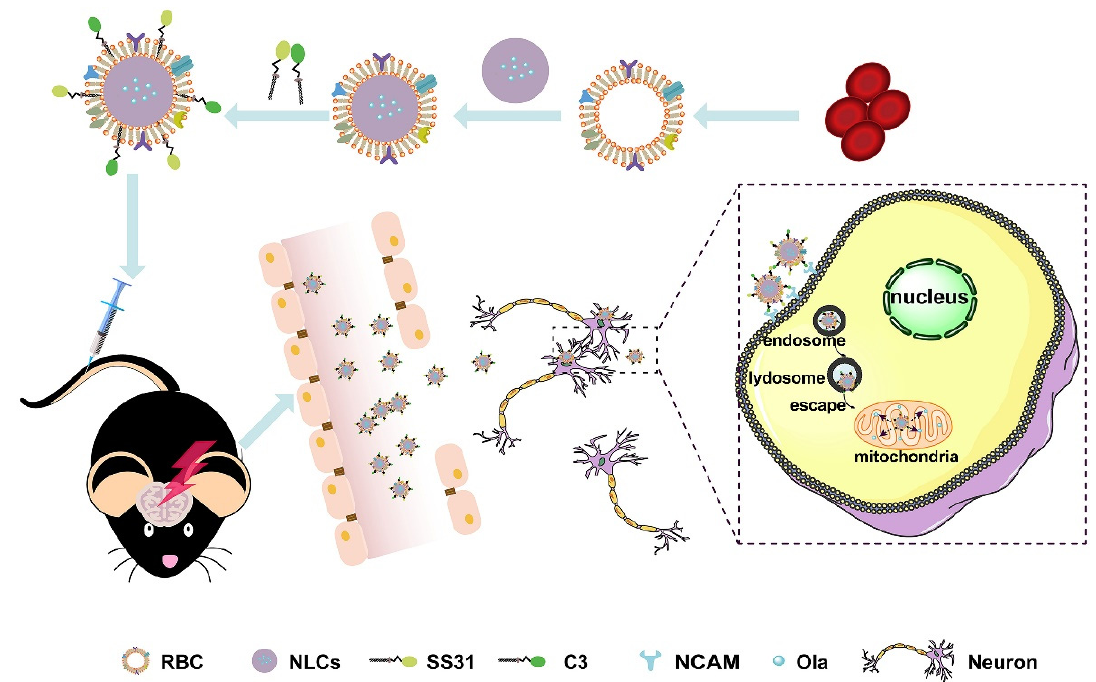
Figure 2. Schematic illustration of erythrocyte membrane-coated nanostructured lipid carriers (RBCNLCs) co-modified with C3 and SS31 peptide for brain neuronal mitochondria targeting to reduce the negative effects of mitochondrial PARP activation. (RBC: red blood cell; NLCs: nanostructured lipid carriers; NCAM: neural cell adhesion molecule; Ola: olaparib). Reprinted with permission from Ref. [50]. Copyright 2022 Elsevier, under the license number 5358651488895.